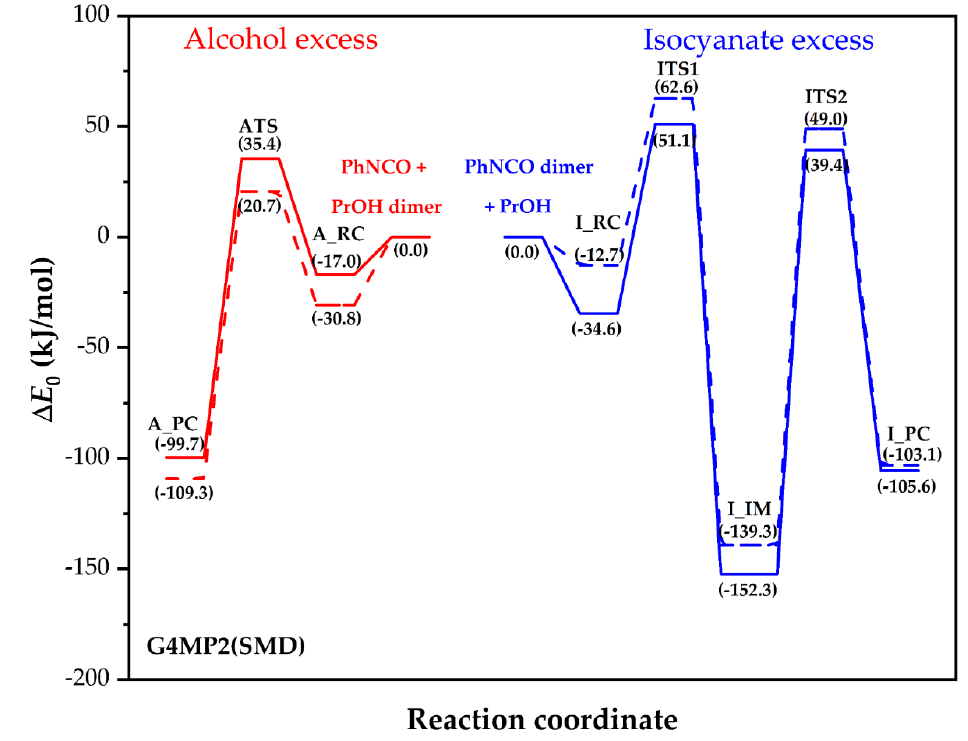
Figure 3. G4MP2 energy profiles (zero-point corrected) for the alcoholic route in solvents 1-PrOH (red solid line) and THF (red dashed line), and for the isocyanate route with 1-PrOH (blue solid line) and THF (blue dashed line).